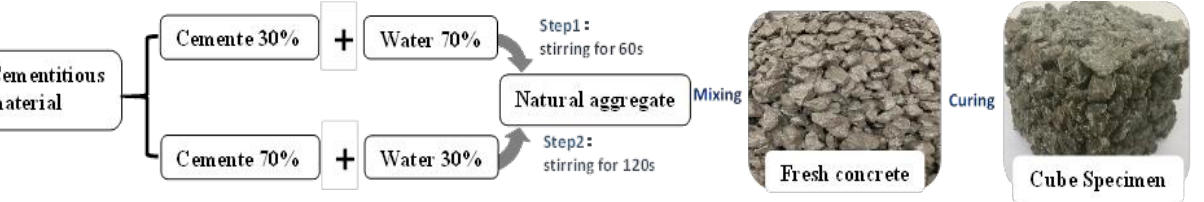
Figure 1. Preparation flow chart.